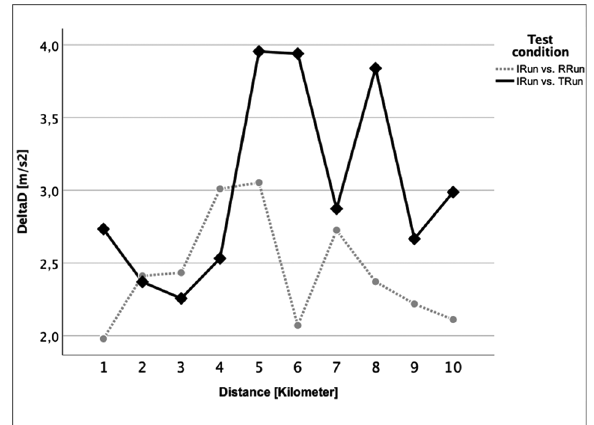
FIGURE 7 d D analysis for the control run vs. the T Run (black solid line with rhombus) and the R Run (grey dotted line with circle). Kilometer 1 and 10 indicate a signi fi cant difference between both conditions.